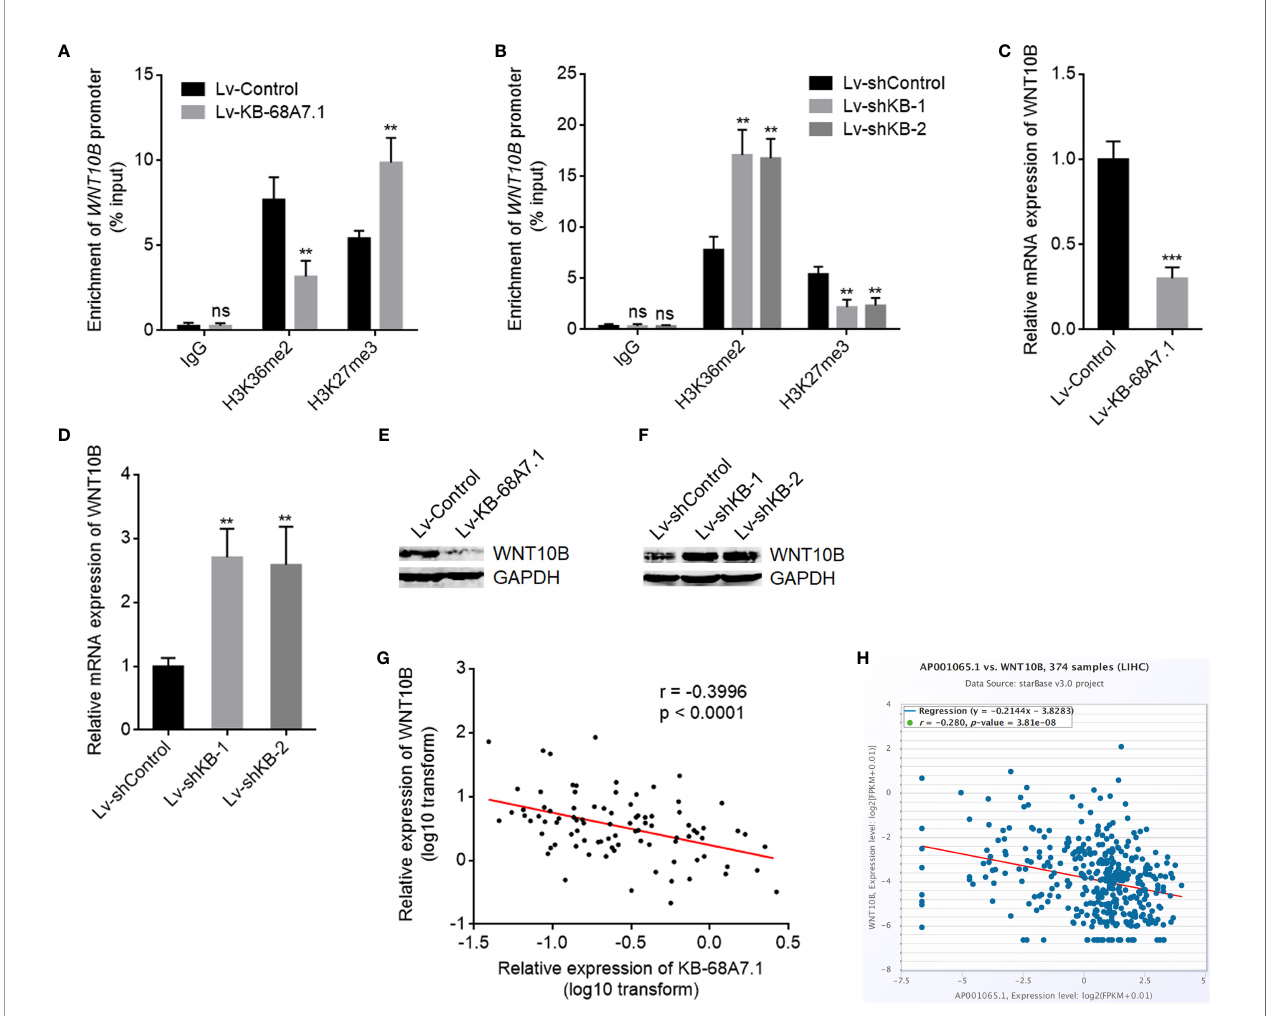
FIGURE 6 | KB-68A7.1 repressed WNT10B transcription. (A) ChIP assays were undertaken in SNU-398 cells with KB-68A7.1 overexpression or control using H3K36me2, H3K27me3 primary antibodies, or non-speci fi c IgG. Enrichment of WNT10B promoter was assessed by qPCR. (B) ChIP assays were undertaken in SNU-398 cells with KB-68A7.1 silencing or control using H3K36me2, H3K27me3 primary antibodies, or non-speci fi c IgG. Enrichment of WNT10B promoter was assessed by qPCR. (C) WNT10B mRNA expression in SNU-398 cells with KB-68A7.1 overexpression or control was measured by RT-qPCR. (D) WNT10B mRNA expression in SNU-398 cells with KB-68A7.1 silencing or control was measured by RT-qPCR. (E) WNT10B protein level in SNU-398 cells with KB-68A7.1 overexpression or control was measured by Western blot. (F) WNT10B protein level in SNU-398 cells with KB-68A7.1 silencing or control was measured by Western blot. (G) The correlation between WNT10B and KB-68A7.1 expression in these 90 HCC tissues. r = − 0.3996, p < 0.0001 by Spearman correlation analysis. (H) The correlation between WNT10B and KB-68A7.1 (AP001065.1) expression in HCC tissues according to TCGA LIHC dataset was analysed by the online in silico tool ENCORI. For Panels (A – D) , results are shown as mean ± SD based on three independent experiments. **p < 0.01, ***p < 0.001, ns, not signi fi cant by two-tailed unpaired t-test (A, C) or one-way ANOVA followed by Dunnett ’ s multiple comparisons test (B, D)